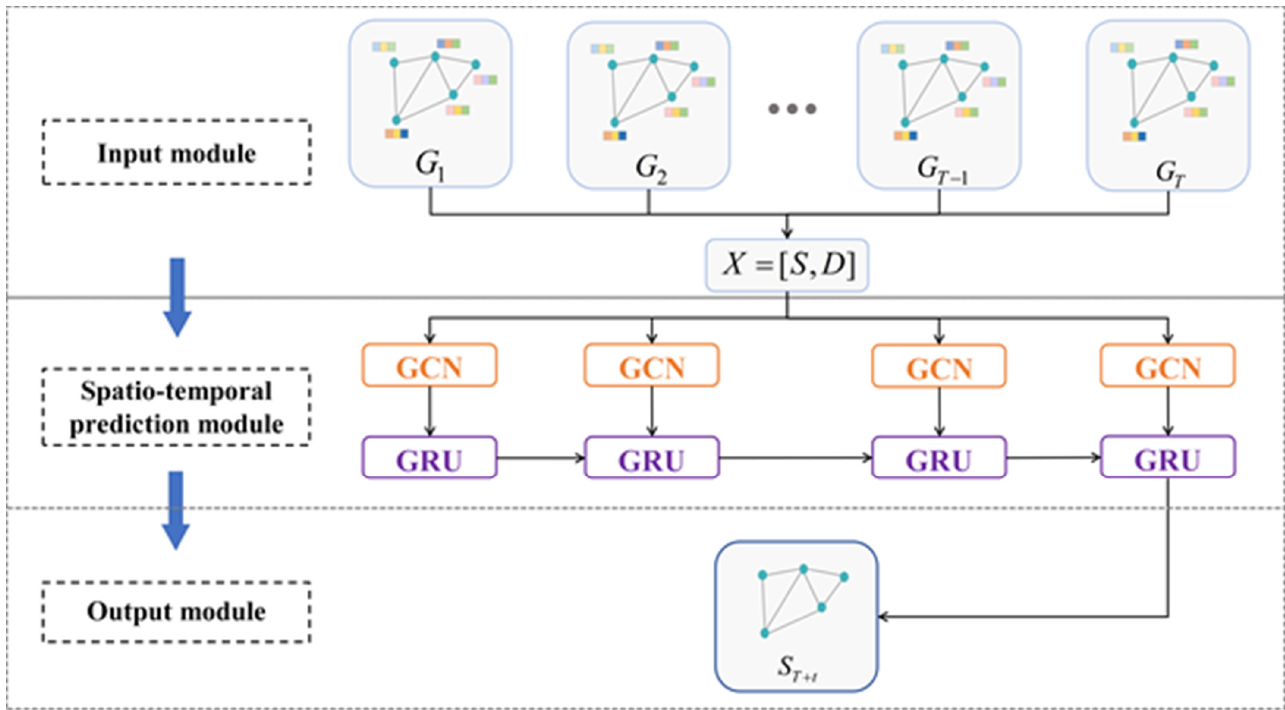
Figure 4. STGCN model framework.